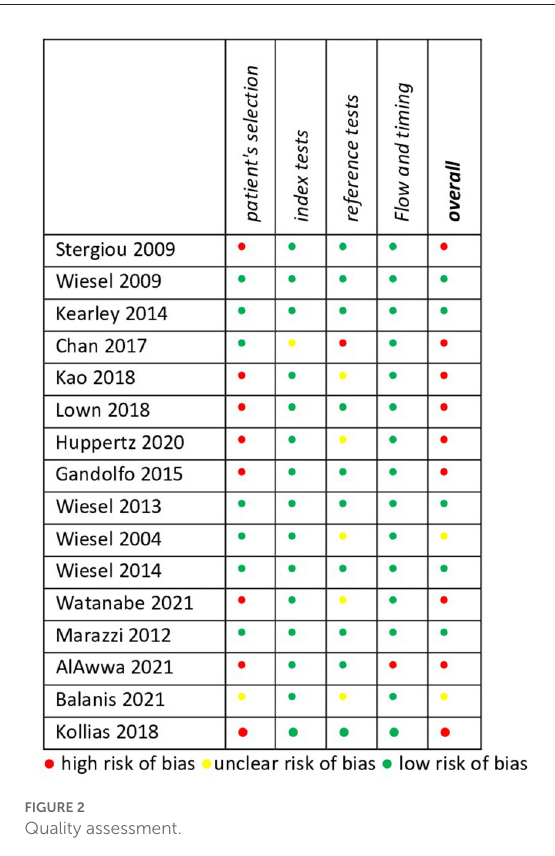
FIGURE2 Quality assessment.